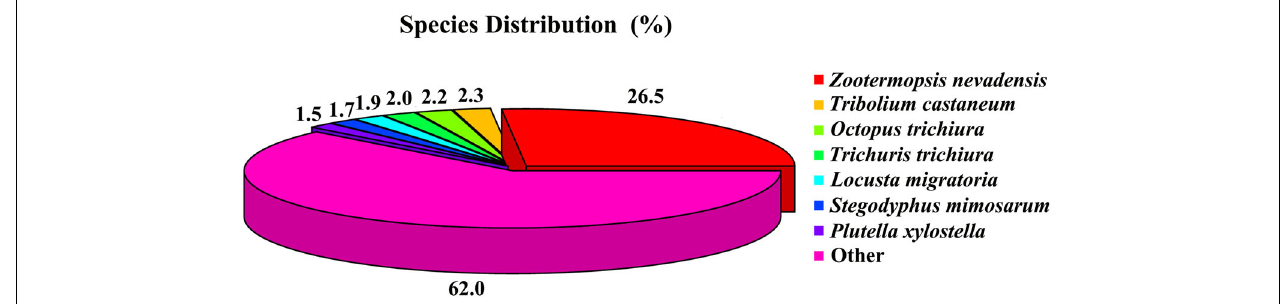
FIGURE 1 | Insect species distribution of C. kiangsu unigenes’ best-hit annotation term in NR database.